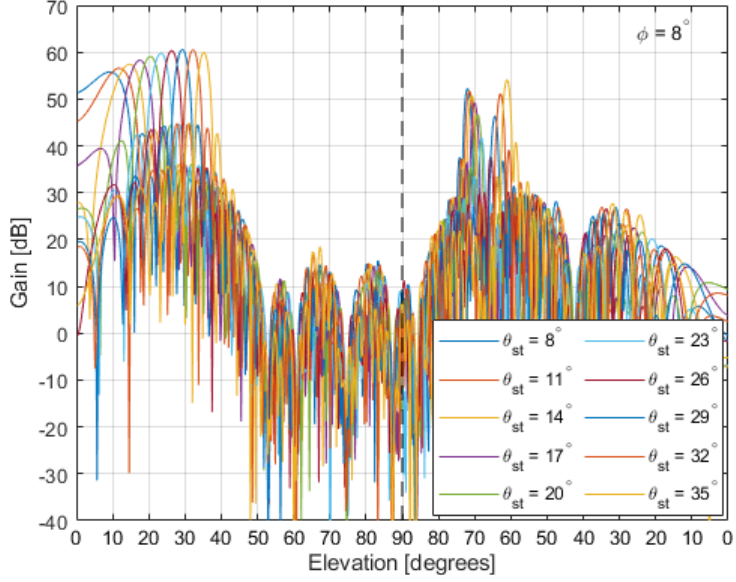
Figure 17. Vertical cuts at 8 ◦ azimuth of the beam patterns of the LOFAR station with the digital beams steered at different θ st and φ st = 8 ◦